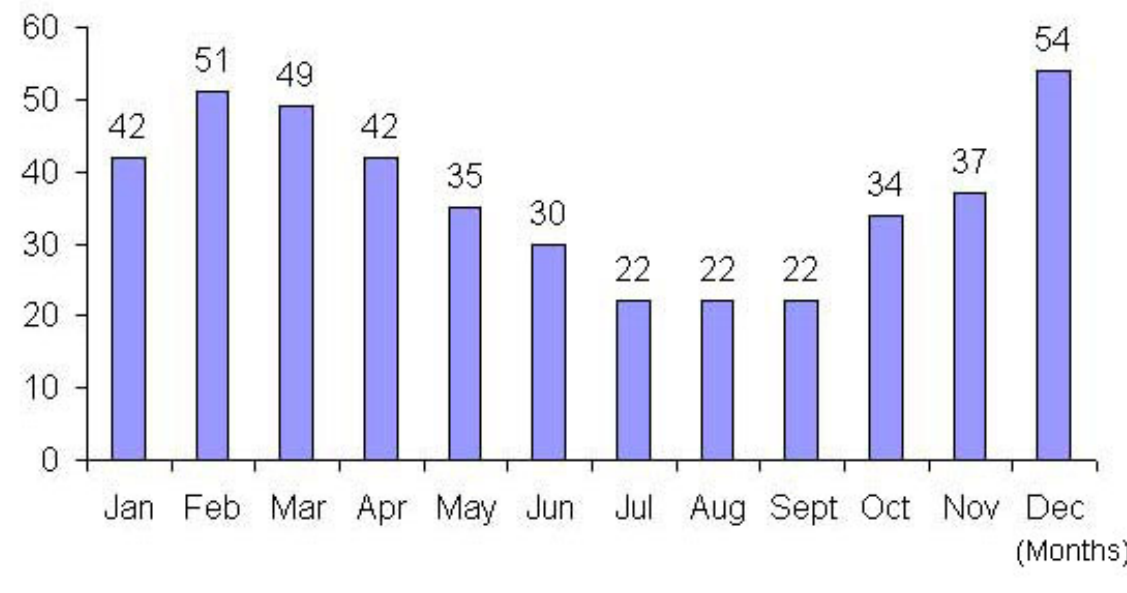
Figure 8: Distribution of accidents according to the month of occurrence.